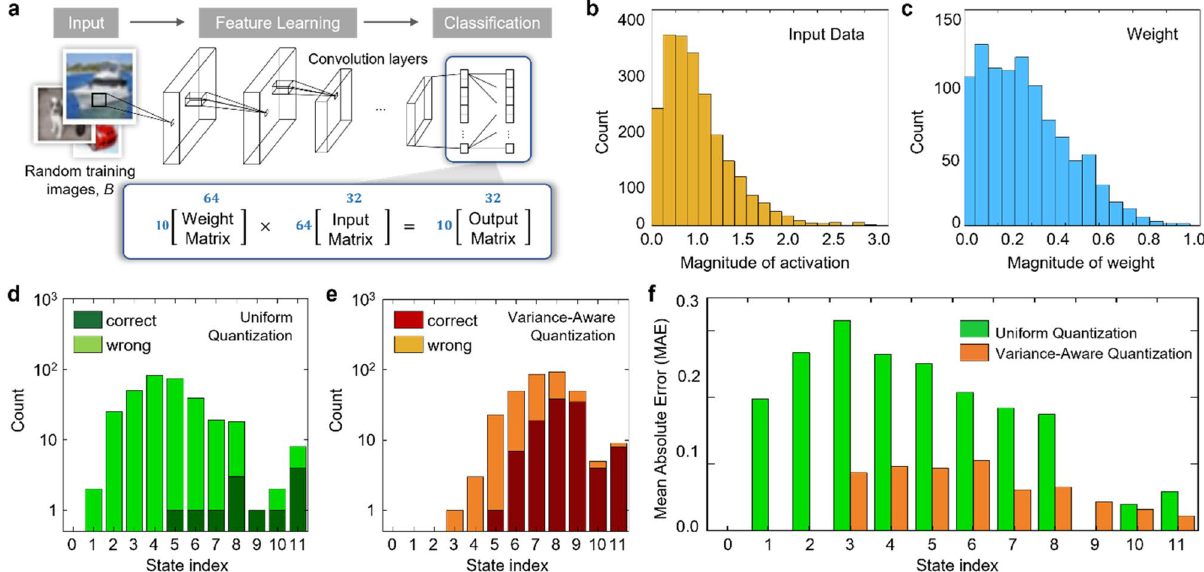
Figure 4. Variance-aware weight quantization for image classification problems. ( a ) An illustration of basic matrix operations for neural network training. The output activation matrix (10 × 32) is computed by multiplying the weight matrix (10 × 64) by the input activation matrix (64 × 32). We collected the data from a neural network designed for image classification tasks (ResNet20 output layer). ( b ) Histograms of the input data (i.e., activations from the previous layer) at the ResNet-20 output layer during training on CIFAR-10 dataset. ( c ) Histograms of the weight values at the same ResNet-20 output layer during training on CIFAR-10. ( d ) Histograms of the number of correct/wrong element-wise uniform quantization of the output matrix. We first get the ground-truth output matrix by quantizing the product of the two floating-point input matrices. We consider the quantization is correct if the quantized output element is the same as the corresponding ground- truth element. ( e ) Histograms of the number of correct/wrong element-wise variance-aware quantization of the output matrix. ( f ) Mean Absolute Error (MAE) of the output matrix. The error is calculated for 12 states